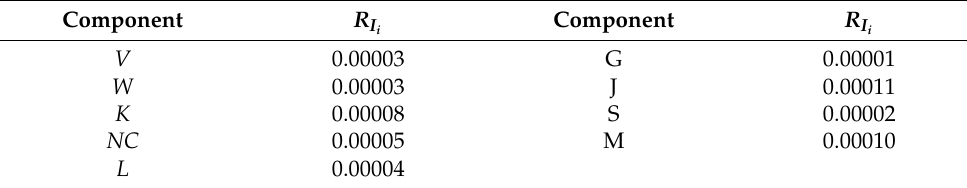
Table 8. Independent risk value of each component of the machining center at 4000